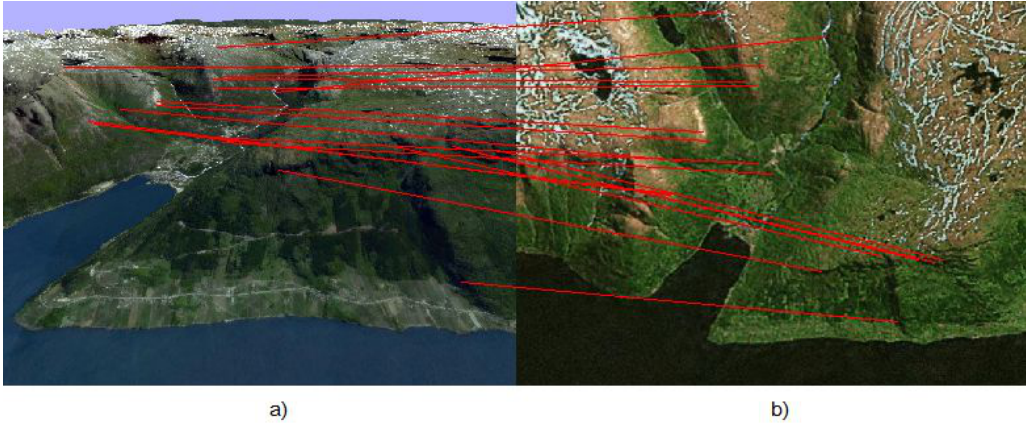
Figure 2. ( a ) Image I c of the on-board camera of the UAV; ( b ) template image loaded in the